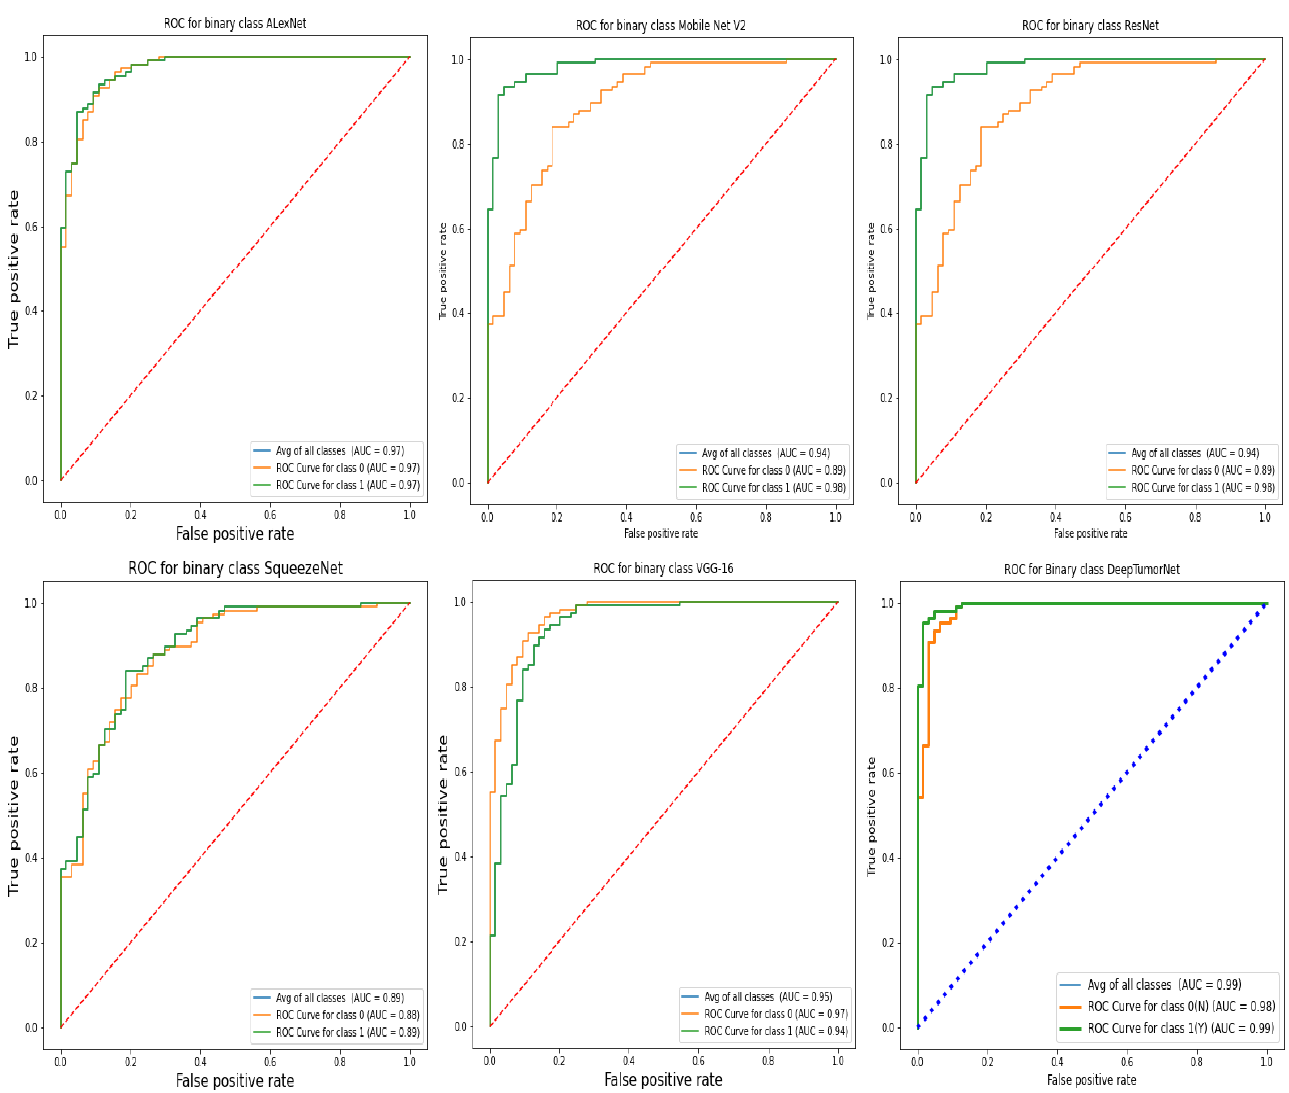
Figure 11. The ROC of the proposed model with other TL model of BTs classification.